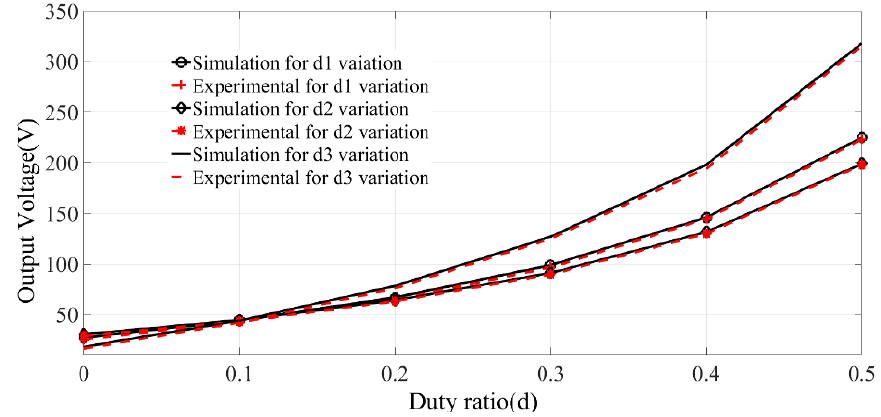
Figure 14. Output voltage variation due to the variation in duty ratios d 1 , d 2 and d 3 (buck-boost operation).